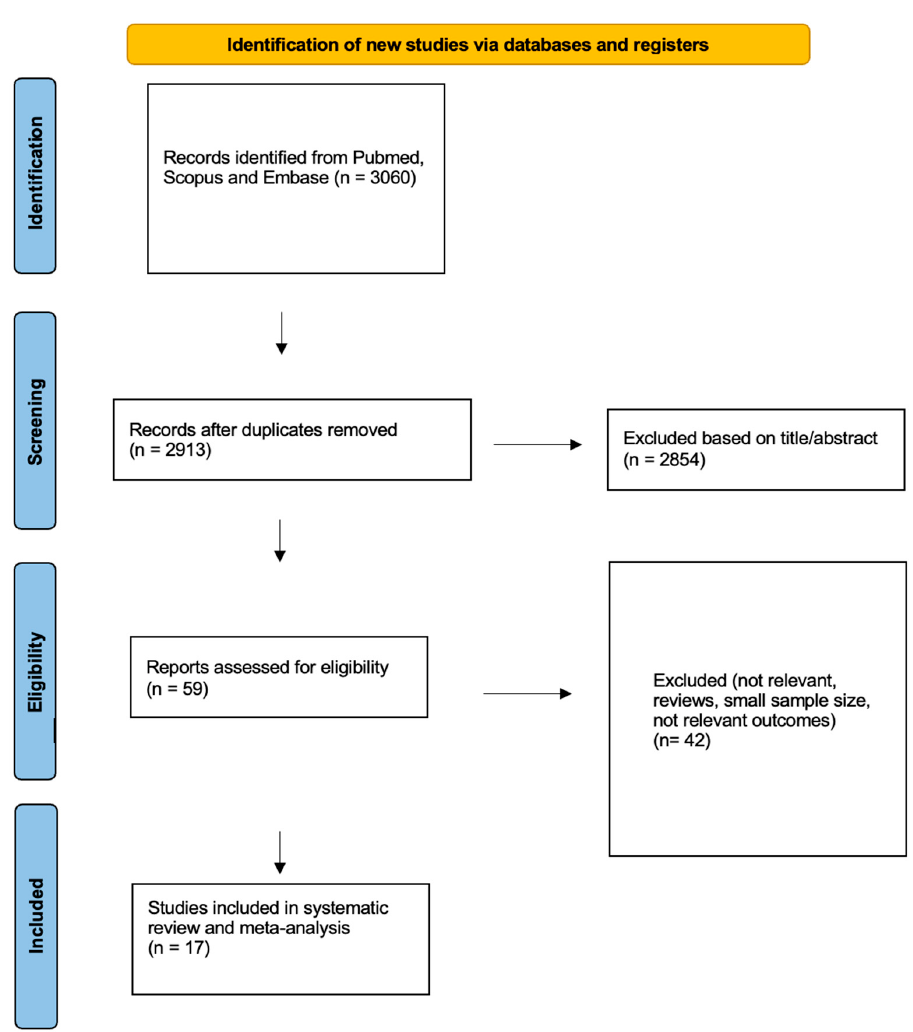
Figure 1. Flowchart for data collection according to PRISMA guidelines.